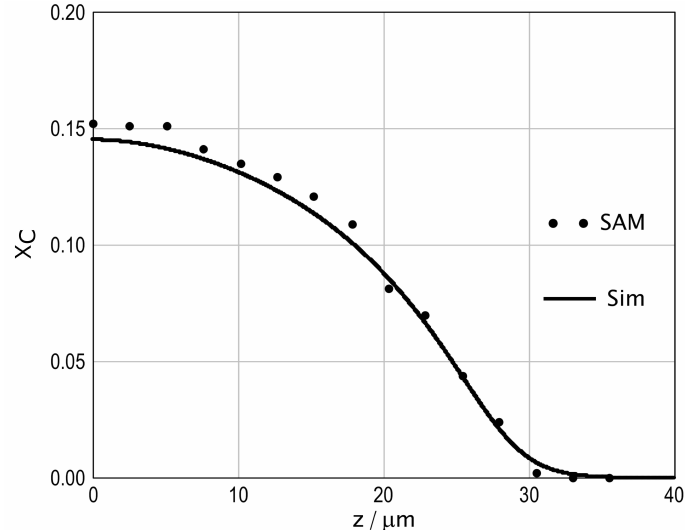
Figure 8. Carbon-fraction–depth profile of an industrial low-temperature gas-phase carburization process, measured by SAM, and corresponding simulated profile, based on concentration-dependent diffusion [16].